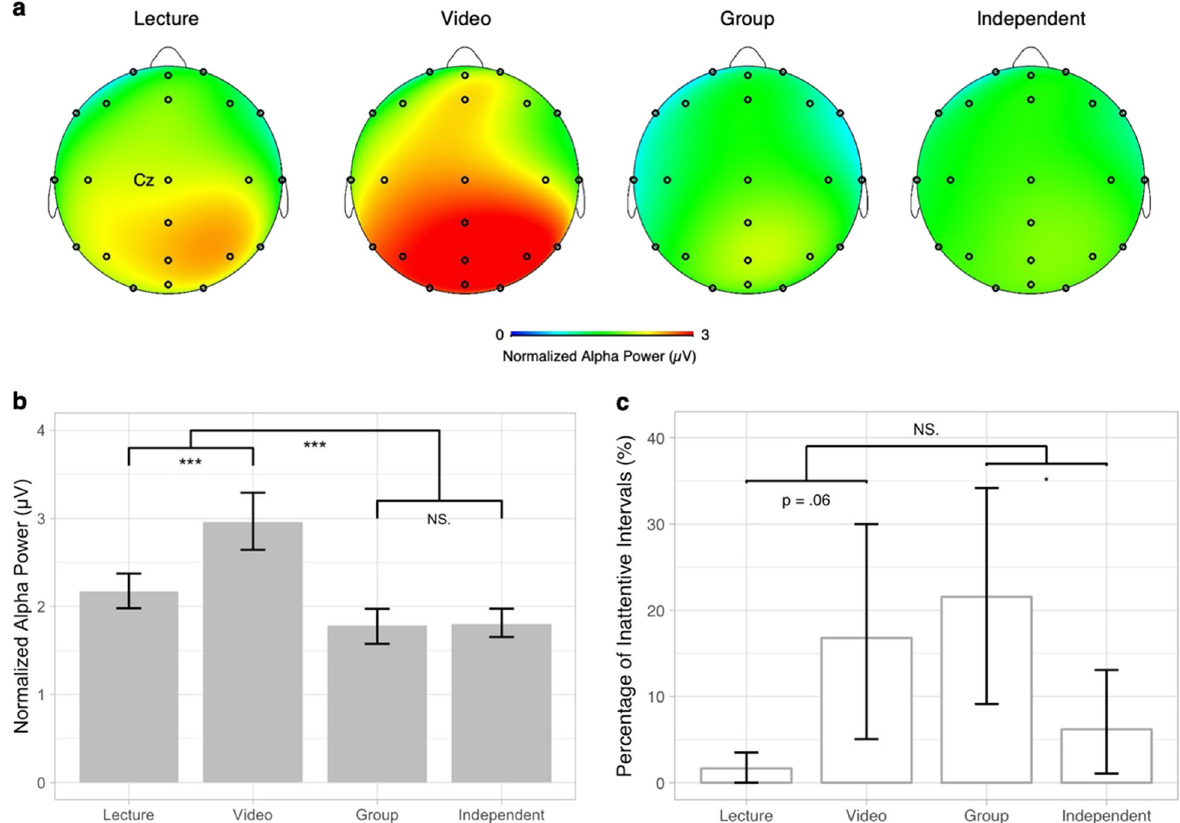
Fig. 1 Effects of instructional activities on student attention as indexed by normalized alpha power and observer rating. a Topographic maps for alpha power revealed that alpha power was higher during lecture and video watching and had a posterior scalp distribution. b Student attention was measured as mean normalized alpha power for each instructional activity, with error bars representing 95% con fi dent interval (calculated by bootstrapped standard error). c Student attention was rated by trained observers as the proportion of inattentive intervals over all codable intervals in each activity, with error bars representing 95% con fi dent interval (calculated by bootstrapped standard error). Same planned contrasts were performed for measures of alpha power and observer rating portrayed in b and c , * p < 0.05, ** p < 0.01, *** p <